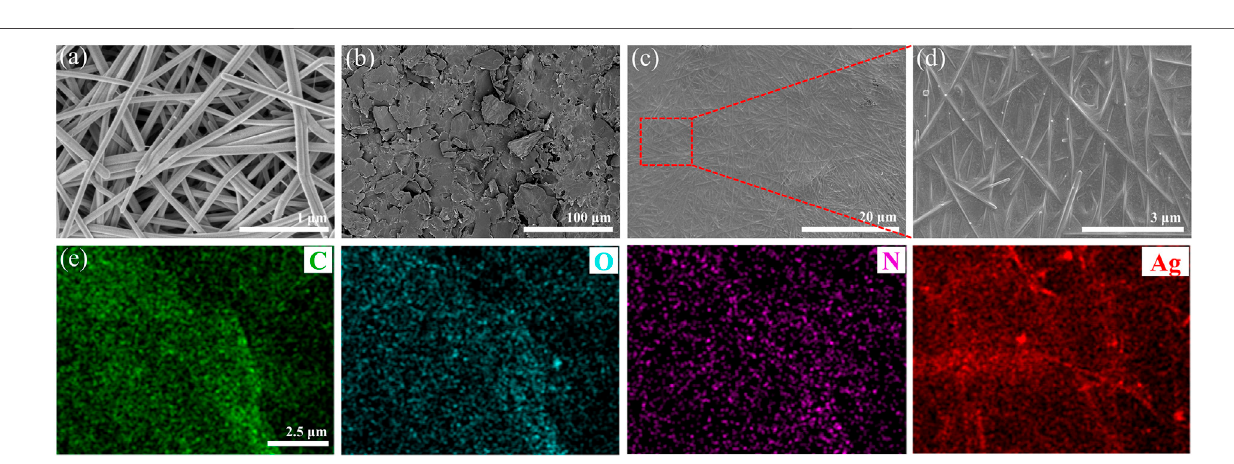
FIGURE 4 | SEM images of AgNWs (A) , GO (B) , and rGO/AgNWs paper (C,D) , target element mapping of rGO/AgNWs paper (E)